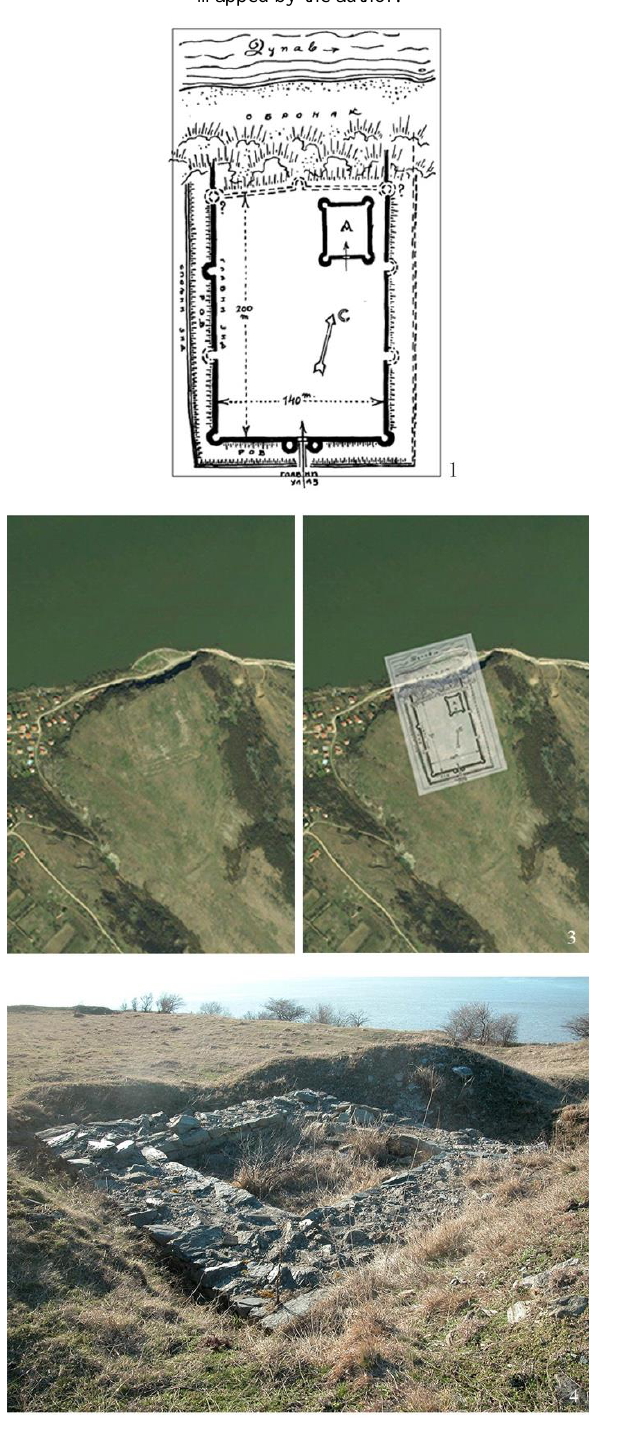
1: plan of the site (DIMITRIJEVIĆ, 1983-84); 2: image of the area from Bing Maps. 3: elaboration by the author, Dimitrijević plan on the aereal view of the site. 4: test on the archaeological site (limes2018.org/limes/ lederata)